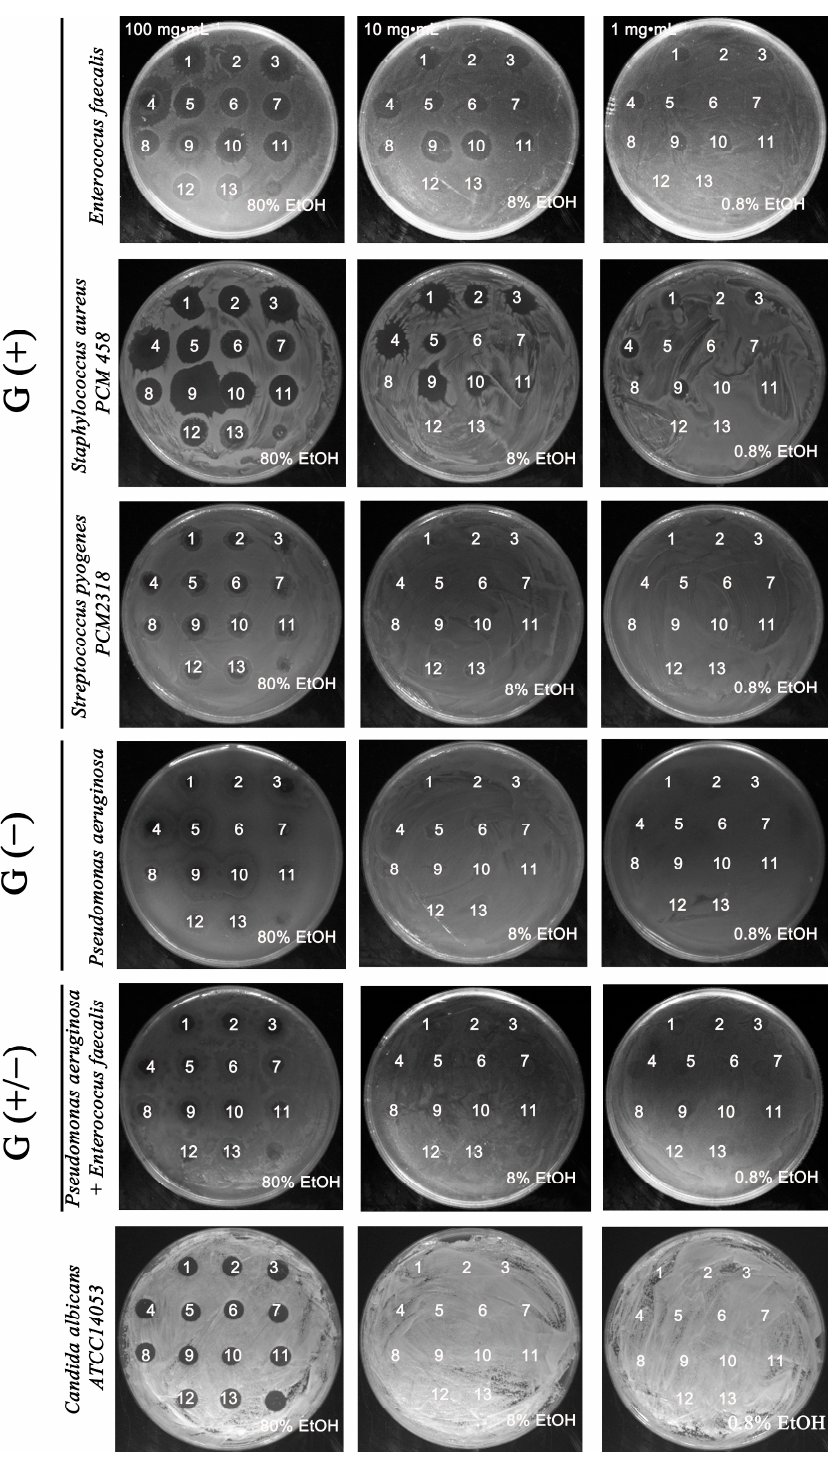
Figure 1. Ethanolic extract-mediated changes (1–13) on microbial growth: G (+) Enterococcus faecalis, Staphylococcus aureus PCM458, Streptococcus pyogenes PCM2318; G ( − ) Pseudomonas aeruginosa; mixed (G (+/ − )) Pseudomonas aeruginosa + Enterococcus faecalis, Candida albicans ATCC14053. The tested microorganisms were treated with microalgae ethanolic extracts (1–13) at 100 mg·mL − 1 , 10 mg·mL − 1 and 1 mg·mL − 1 surface spotted onto the indicator lawn—NA agar (bacteria) and YPD agar (Candida) media. Representative micrographs of bacterial and yeast culture dishes.